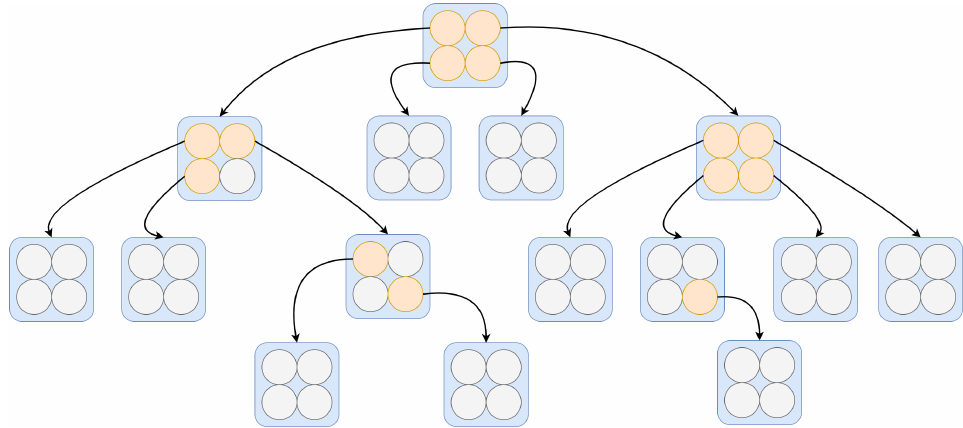
Figure 2. An example of a tree generated by the TESSOM